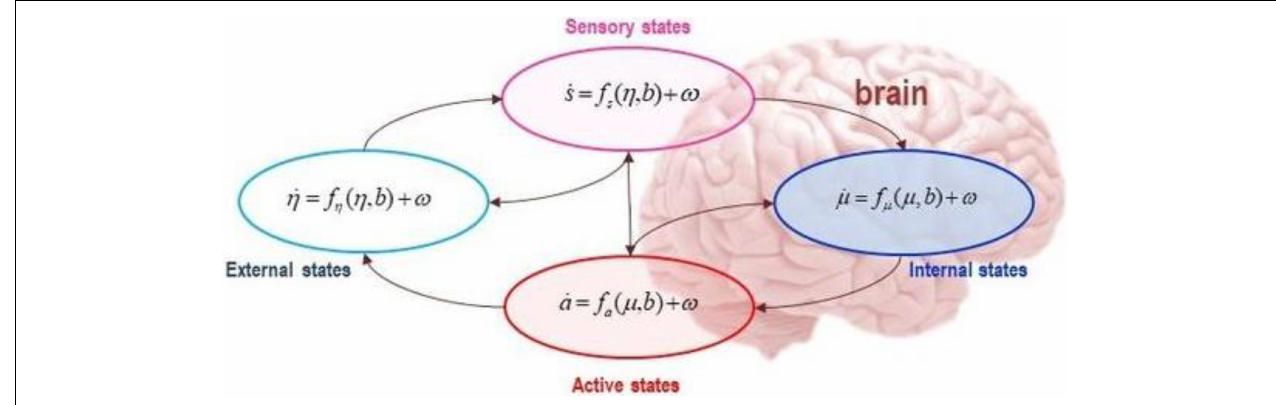
FIGURE 7 | The figure depicts a Markov blanket partitioning of conditionally independent states, internal (blue) and external (cyan); and blanket states, active (red) and sensory (magenta), directly influencing one another. The arrows show that while internal states depend on blanket states (sensory and active states), external states depend on external states and blanket states. This means that internal and external states indirectly influence one another by virtue of the influences between blanket states: i.e., sensory and active states. The Markov blanket formalism is scale free, which means that it can be applied to any scale of the physical world to explain the exchanges and influences amongst open systems. Applied to the brain, the formalism can be applied such that internal states correspond to a single neuron, a cortical microcircuit, a region, or a network (see Hipólito et al., 2021b for a detailed